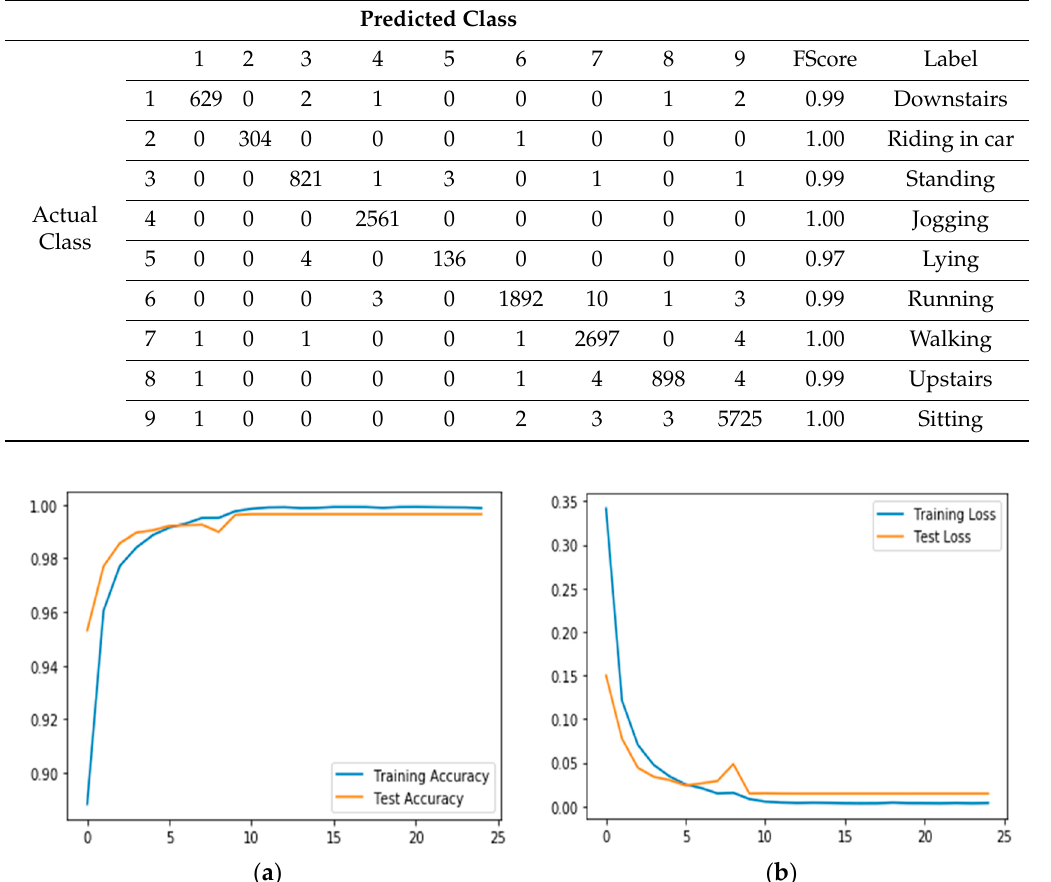
Table 3. Confusion Matrix for Inertial + Ambient Sensing. Table 2. Confusion Matrix for Inertial Sensing .